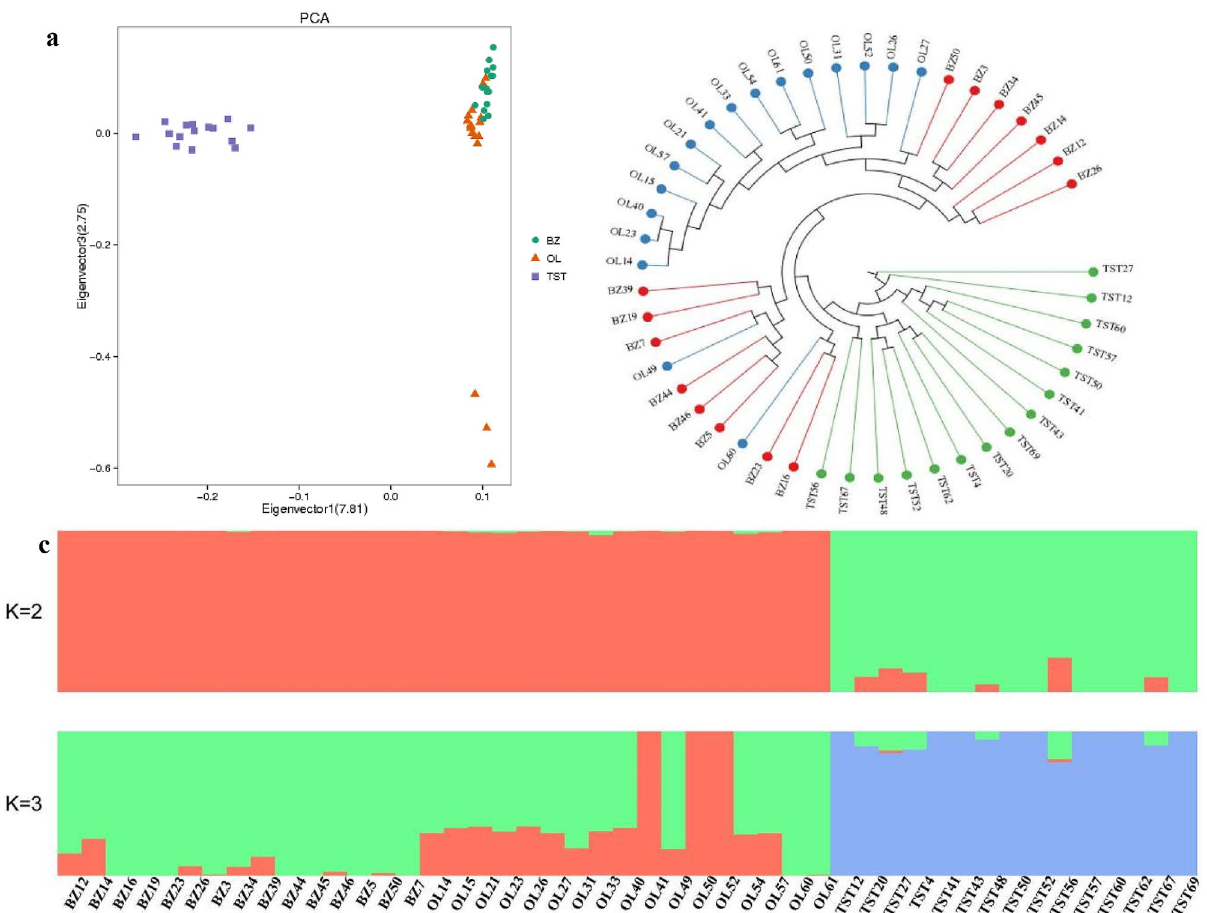
Figure 1. Population genetics analyses of samples. ( a ) Principal component analysis (PCA) results of three sheep breeds. ( b ) NJ tree constructed using p-distances between individuals. ( c ) Population genetic structure of the sheep inferred from the program FRAPPE v1.1. The length of each colored segment represents the proportion of the individual genome inferred from ancestral populations (K = 2 or